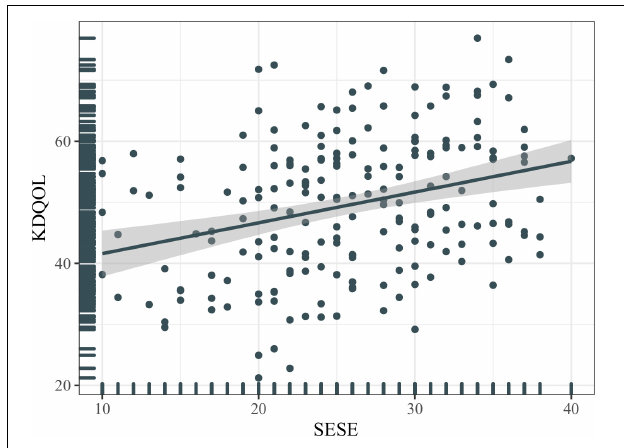
FIGURE 2 | Correlation between exercise self-efficacy and health-related quality of life (HRQOL). KDQOL, kidney disease quality of life; SESE, exercise self-efficacy scale.